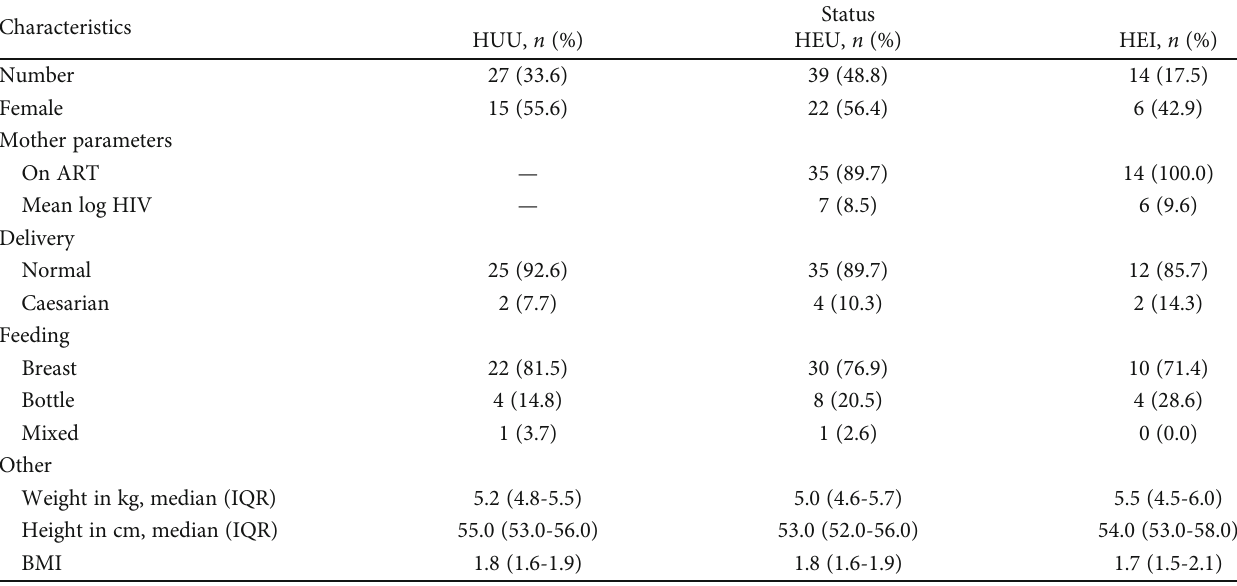
Table 1: Demographic and clinical characteristics of the study participants.